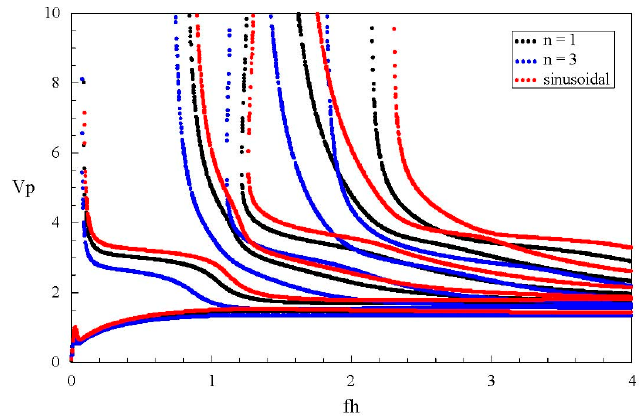
Figure 12. Phase velocity dispersion curves of the Lamb-like wave.